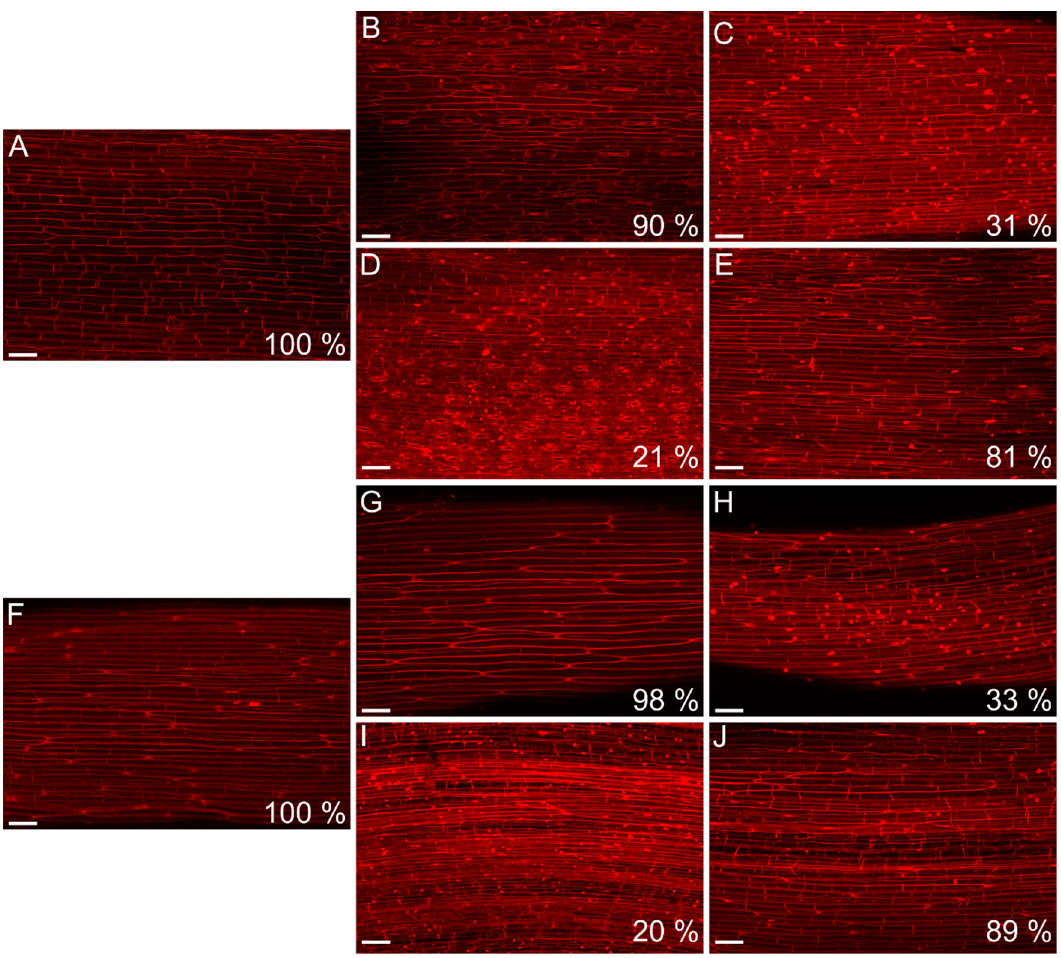
Figure 7. The effect of DHNQ combined with NQ-2-OH or NQ on the membrane integrity and cell viability in the maize coleoptile segments. ( A ) control medium, ( B ) 1 nM (DHNQ + NQ-2-OH); ( C ) 10 nM (DHNQ + NQ-2-OH); ( D ) 1 nM (DHNQ + NQ); ( E ) 10 nM (DHNQ + NQ); ( F ) 100 µM IAA; ( G ) 1 nM (DHNQ + NQ-2-OH) + IAA; ( H ) 10 nM (DHNQ + NQ-2-OH) + IAA; ( I ) 1 nM (DHNQ + NQ) + IAA; and ( J ) 10 nM (DHNQ + NQ) + IAA. The cell viability is presented as the percentage of living cells.